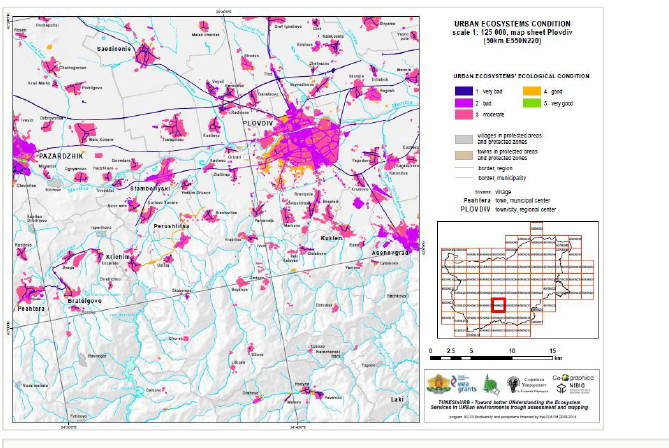
Map of the urban ecosystem condition based on the integrated index of spatial structure (Note: this is a low quality copy, the original map being given in Suppl. material